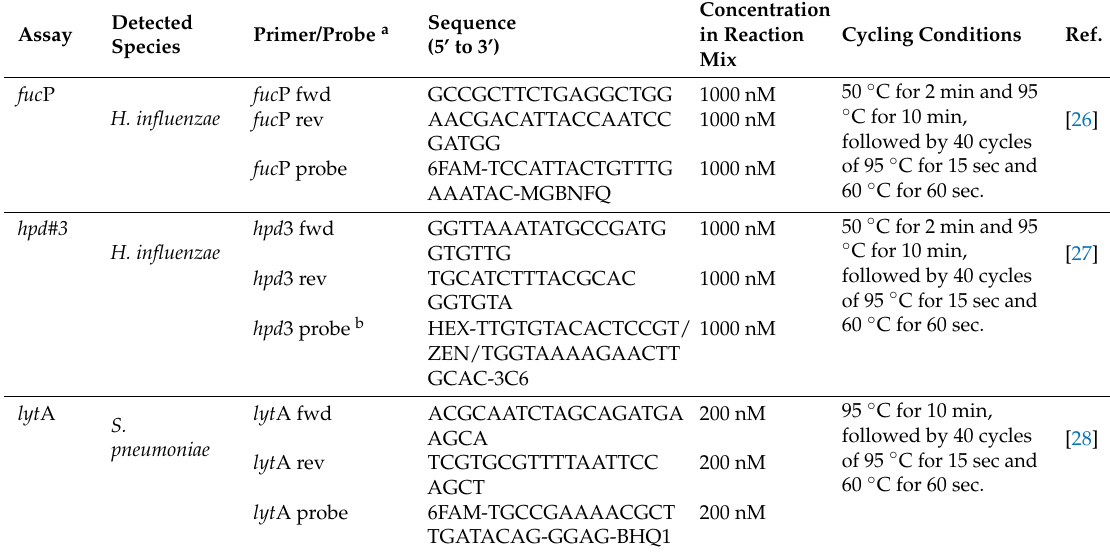
Table 1. qPCR primers, probes and